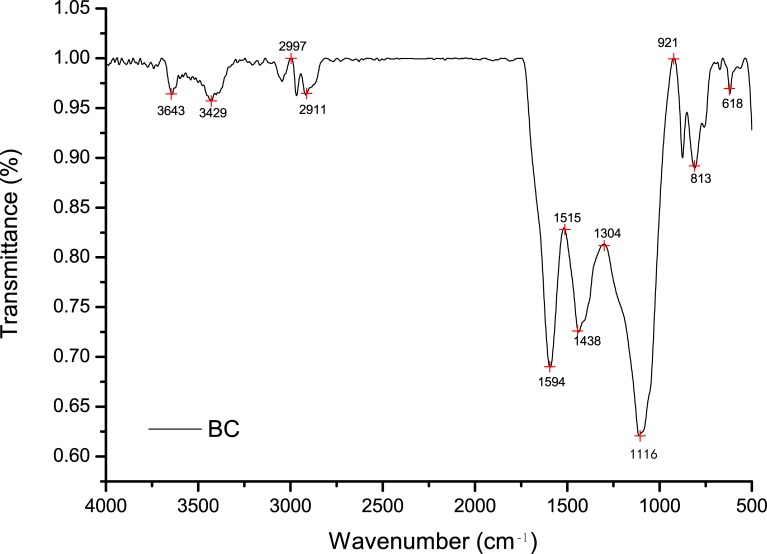
FTIR spectra of maize straw biochar at 450°C.